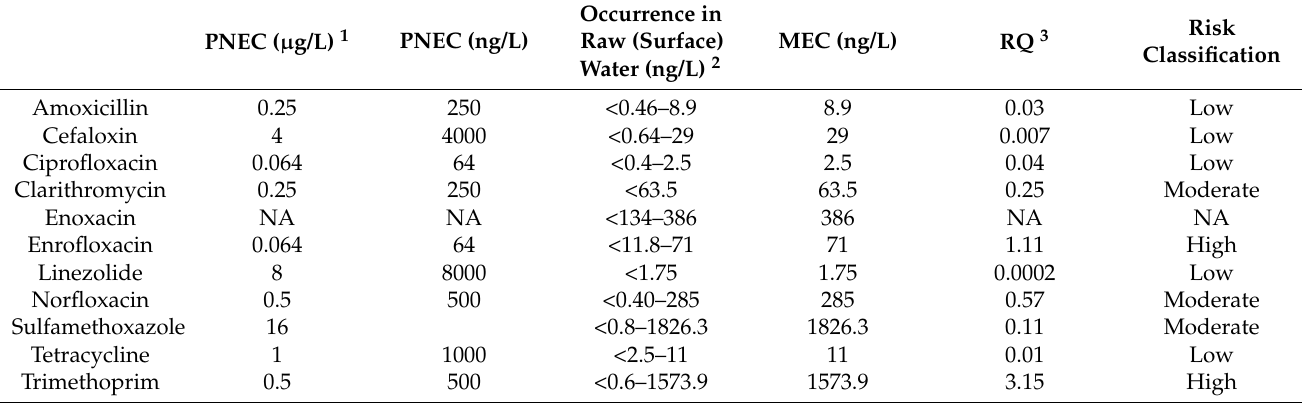
Table 5. Risk estimation of antimicrobial resistance induction by antibiotics found in Brazilian surface